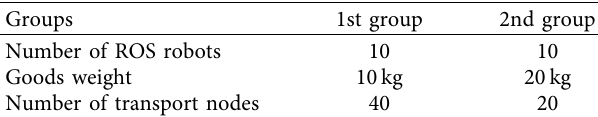
Table 2: Simulation experiment parameter